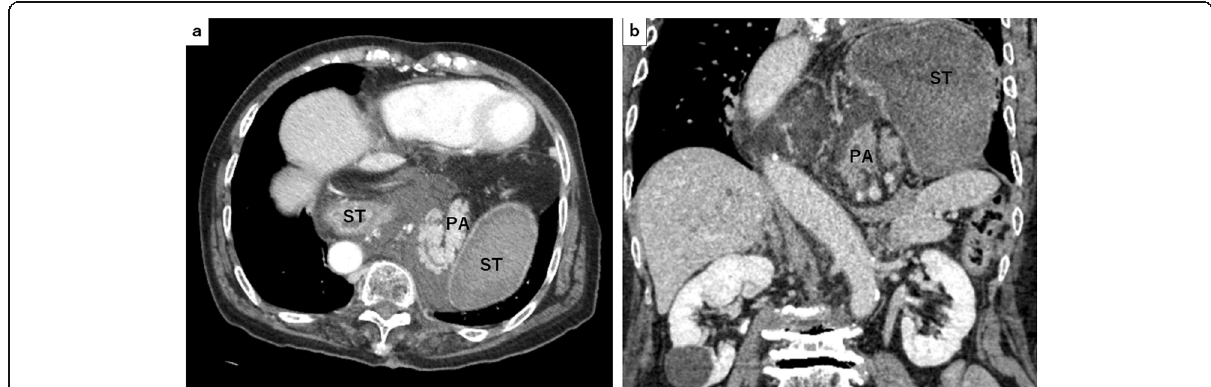
Fig. 2 Enhanced computed tomography (eCT) revealed a large HH involving the entire stomach and pancreatic body and tail sliding through the hiatal orifice into the mediastinum, with peripancreatic fluid in the posterior mediastinal space as a sequel to pancreatitis. In axial view ( a ) and in coronal view ( b ). ST: stomach, PA: pancreas